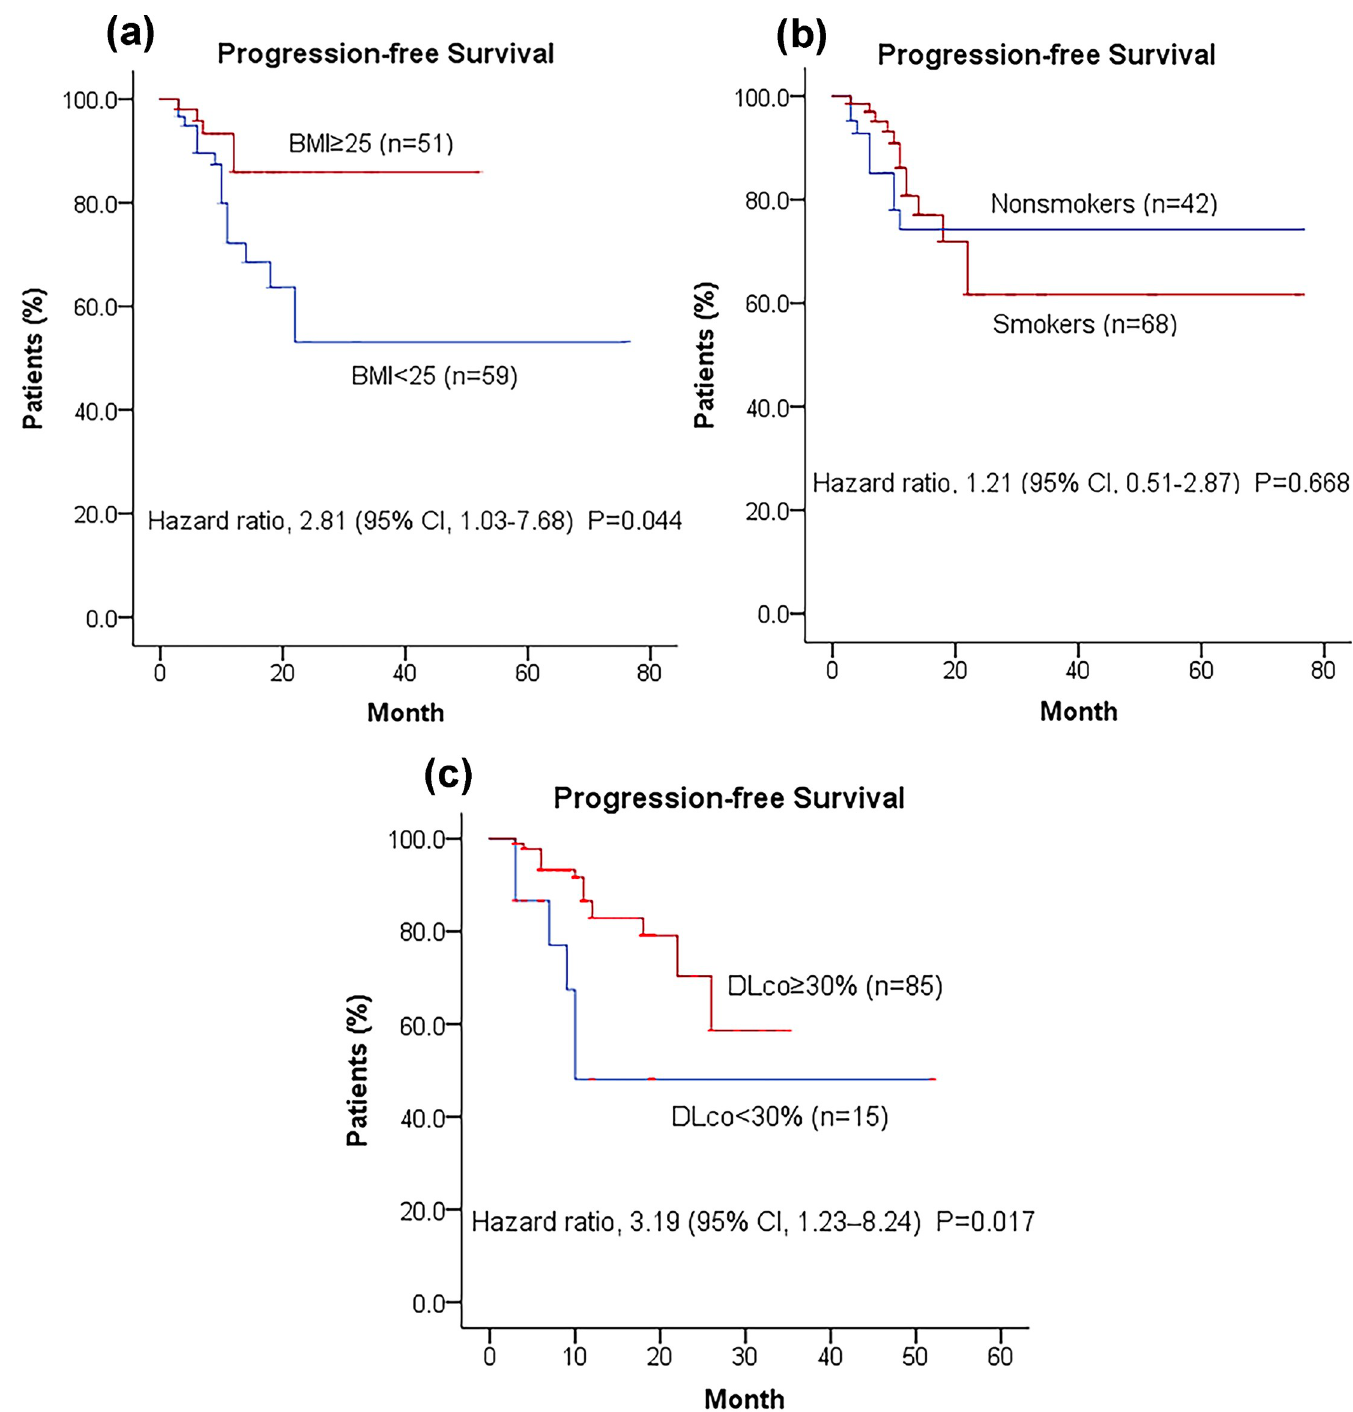
Fig 2. The Kaplan–Meier distribution for the probability of progression-free survival on IPF patients. https://doi.org/10.1371/journal.pone.0228390.g002 FVC predicted and DLco predicted of IPF patients in the progressive group dropped dramati- cally after treatment, though without statistically significant difference compared with the baseline values ( P = 0.055 and P = 0.185 respectively). Statistically significant differences were